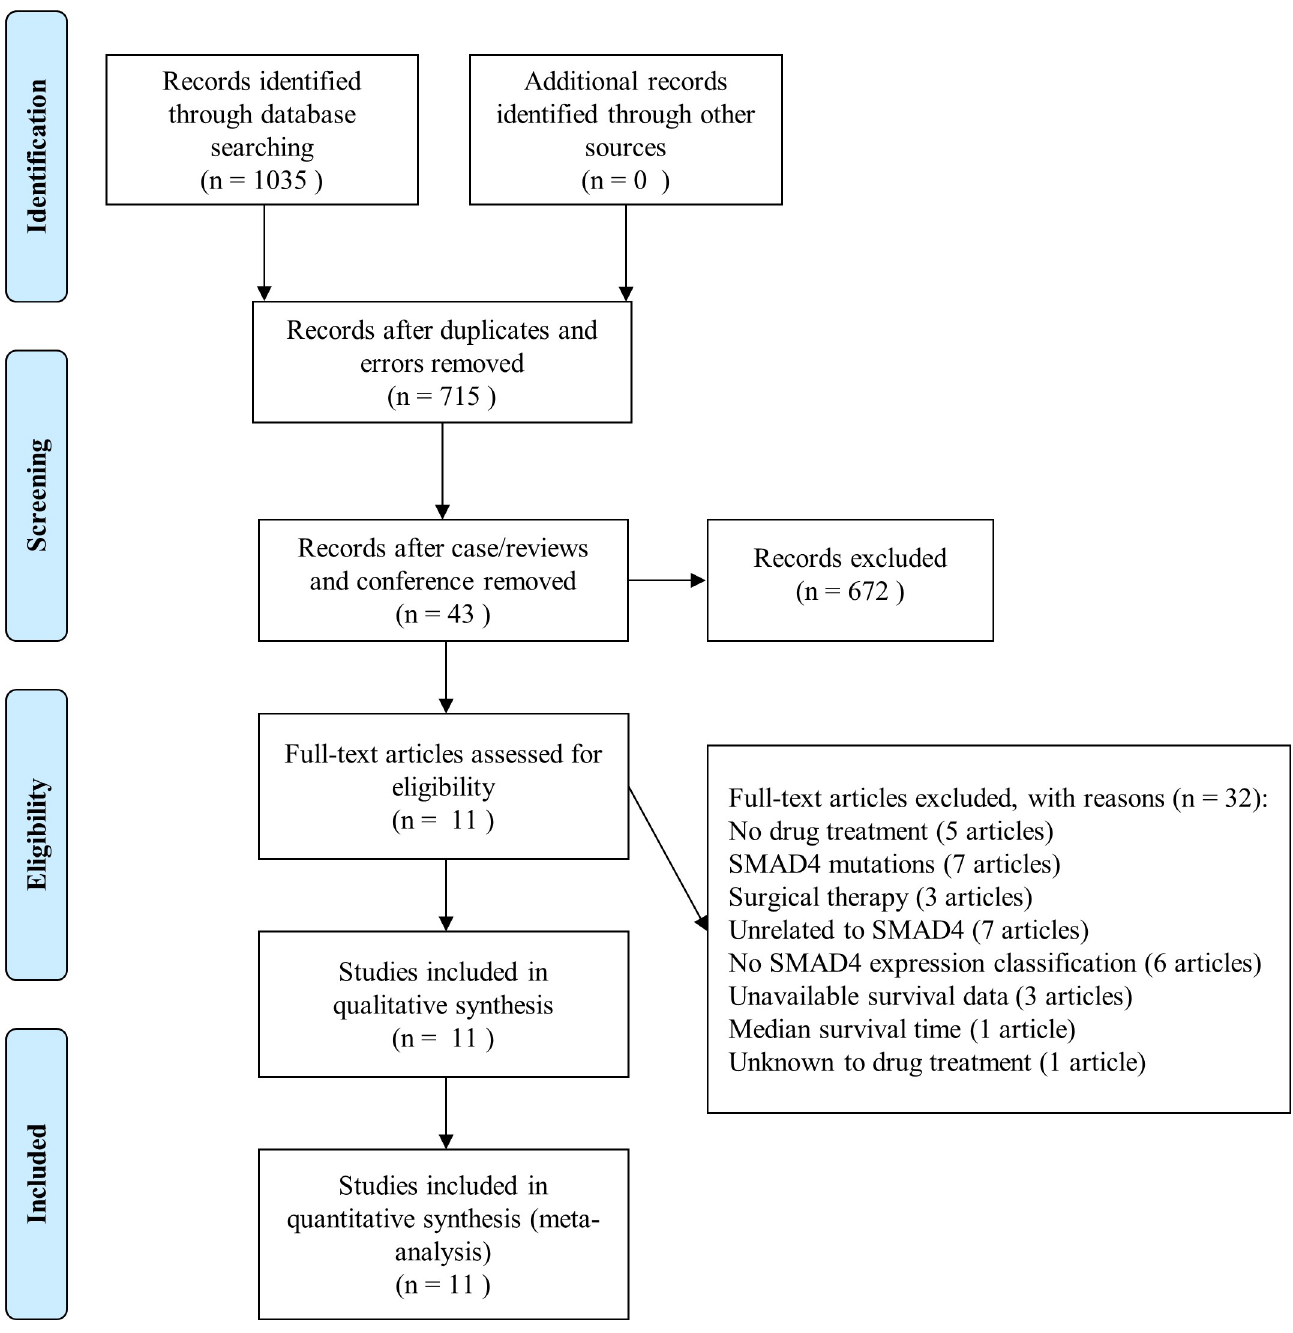
Fig 1. Methodological flow chart for the selection of papers in meta-analysis. ( Identification ) 1035 articles were identified from 4 online databases. ( Screening ) 992 records were excluded: 303 duplicated records and 17 error records; 111 cases/reviews and 258 conferences; 303 records unrelated to four key terms (patient � , cancer � /adeno � , chemo � and SMAD4/DPC4). ( Eligibility ) 32 records were excluded: 5 records did not include drug treatment in the SMAD4 group; 7 records involved SMAD4 mutation with unknown protein function; 3 records were under surgical therapy; 7 records were unrelated to SMAD4 expression in cancer progression and survival; 6 records were without SMAD4 expression classification in chemotherapy subgroup; 3 records were unavailable in survival data; 1 record only had median survival time without survival curve and 1 record was unknown for drug treatment. ( Included ) 11 studies were finally chosen for meta- analysis. n, the number of the selected